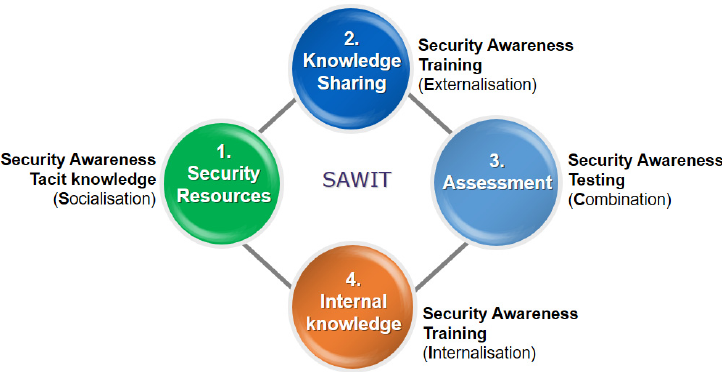
Figure 5. SAWIT conceptual model.